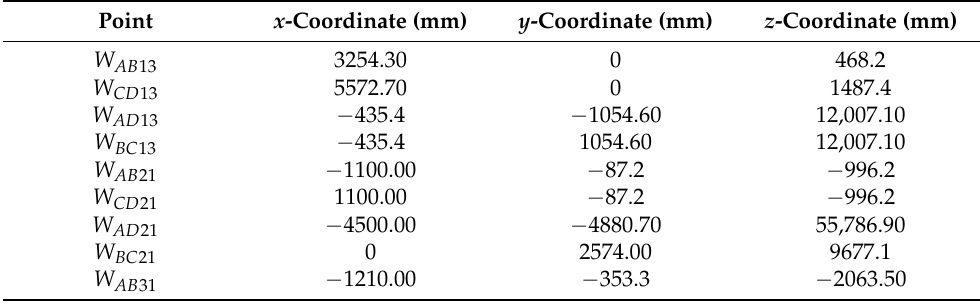
Table A1. The coordinates of the vertices W ABij , W CDij , W ADij , W BCij (for i, j = 1, 2, 3) of the polyhedral reference network Γ 1